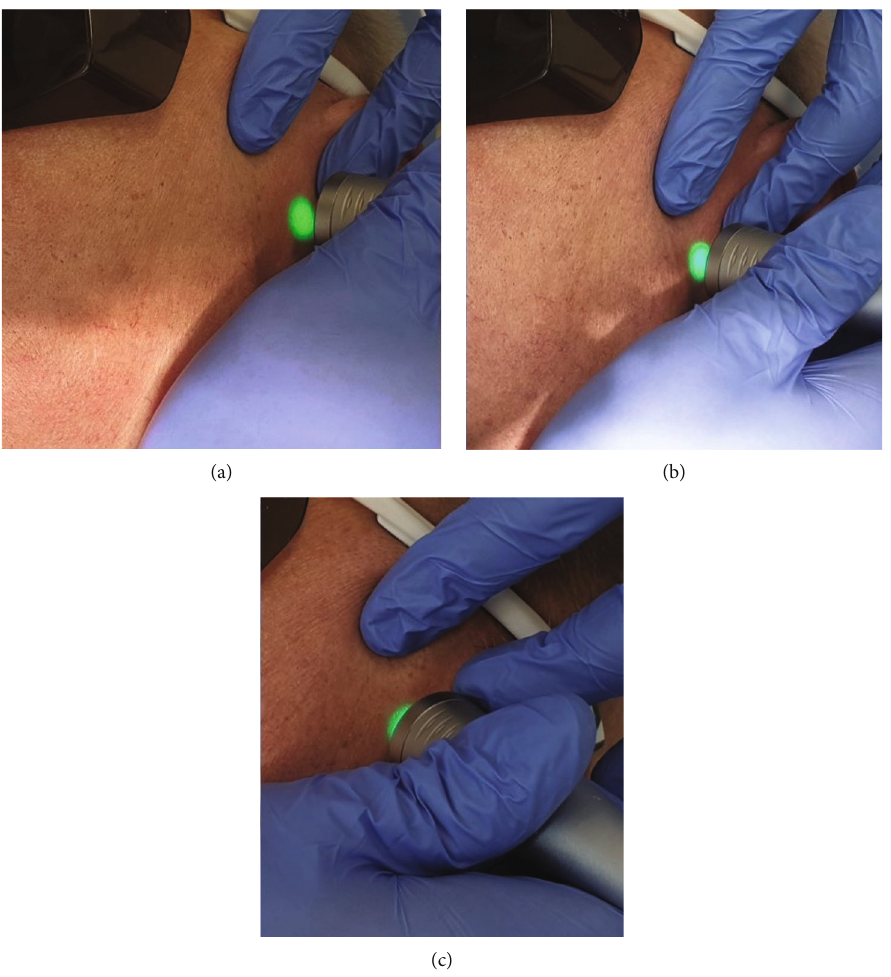
Figure 4: Photobiomodulation using LightWalker laser (Fotona d.o.o.) was performed with a fl at-top Nd:YAG handpiece. The laser was applied in three places: posteriorly (a), above (b), and anteriorly (c) to the condyle. Four treatment sessions were performed.